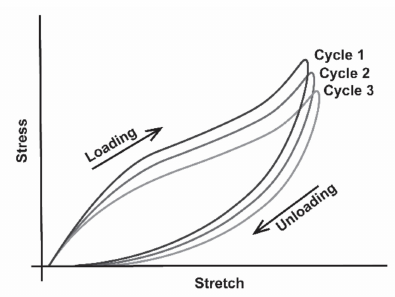
Figure 5. Theoretical example of hysteresis loops indicative of cyclic softening. Cyclic softening occurs when the peak stress of a material decreases with an increased number of